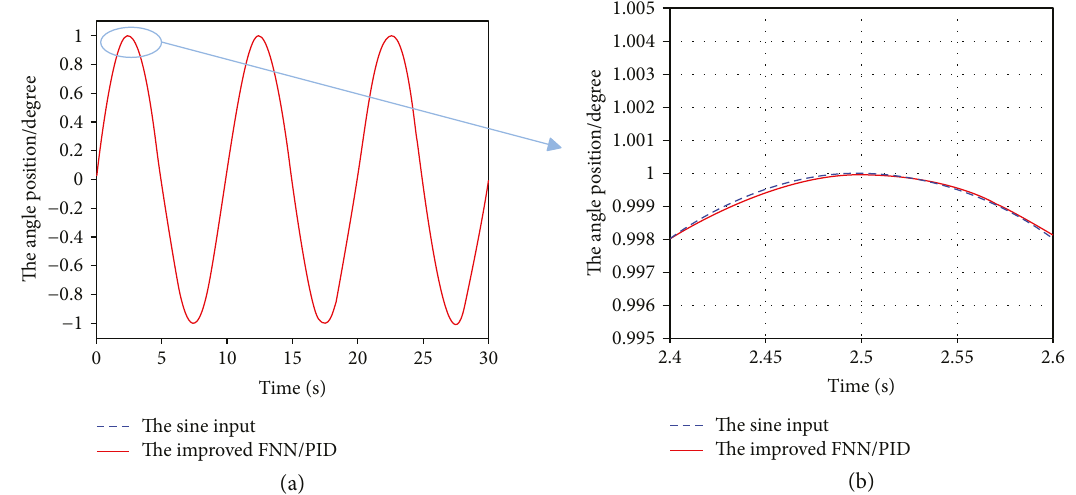
Figure 12: The sine response curve under the friction disturbance: (a) improved FNN/PID compound control schemes and (b) the partial enlargement.